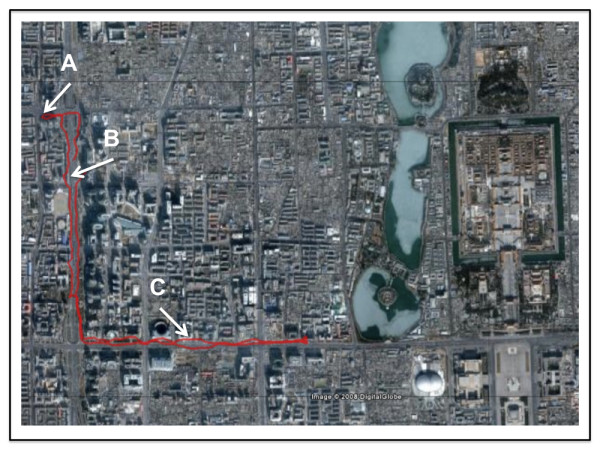
City centre route chosen in central Beijing. A representative recording from the GPS device contained in the monitoring backpack is shown. The walk goes from the Fuwai Hospital (A), along the inner ring road (B) and towards the city centre (C) before turning back. Image courtesy of Google™ Earth.